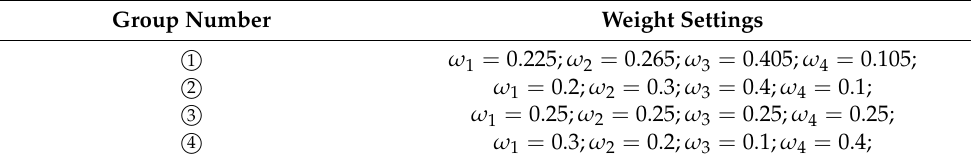
Table 4. The first group of weight settings is determined based on the maximum entropy